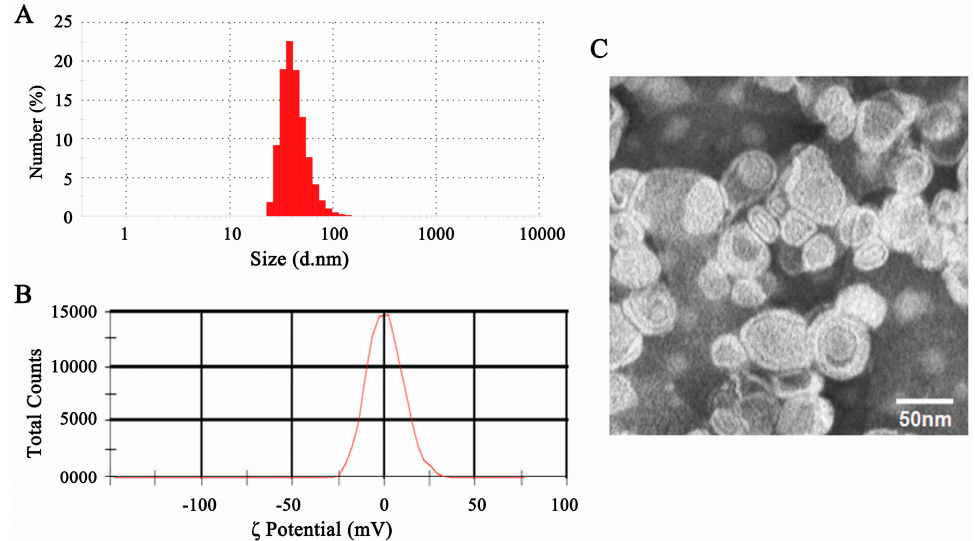
Figure 3. The features of ACUPA-M-WOG. ( A ) Particle size distribution of ACUPA-M-WOG; ( B ) ζ potential of ACUPA-M-WOG; ( C ) TEM image of ACUPA-M-WOG.